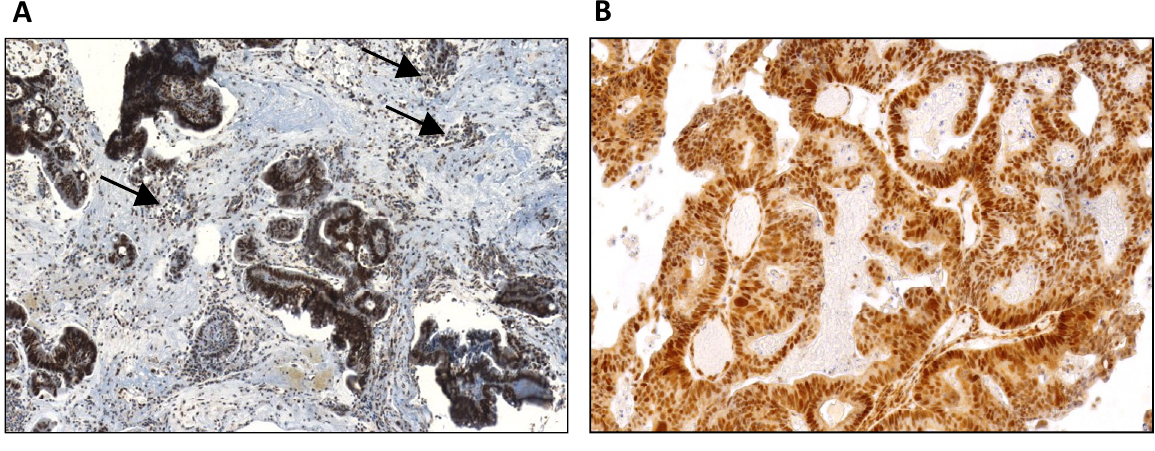
Figure 2. hMLH1 and hMSH2 expression in ITAC. ( A ) Nuclear immunoreactivity for hMLH1 in a papillary type of ITAC both in tumor cells and lymphocytes cells (arrows); ( B ) Nuclear immunoreactivity for hMSH2 in a papillary type of ITAC in tumor